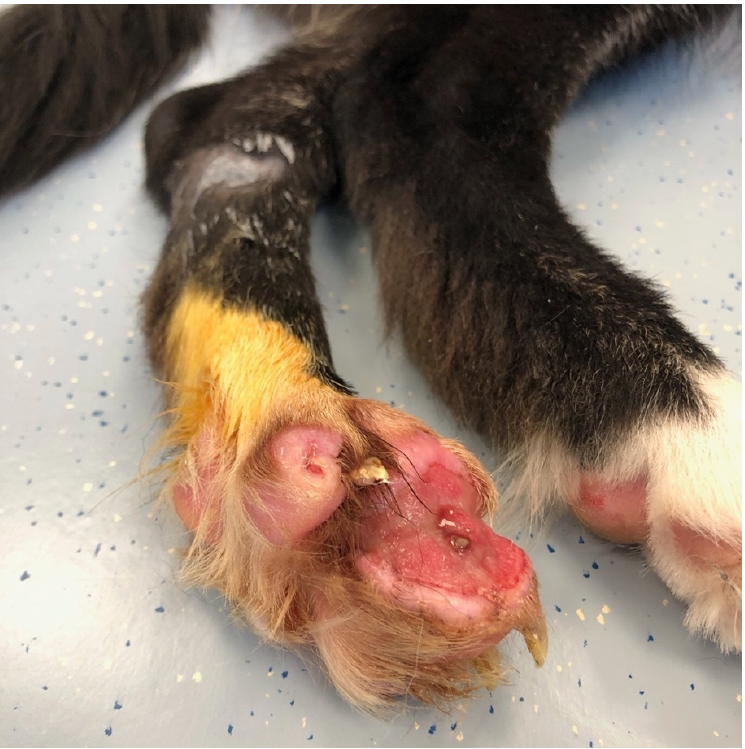
Figure 1. Large wounds on the lateral part of digit II and III of the left hind limb.